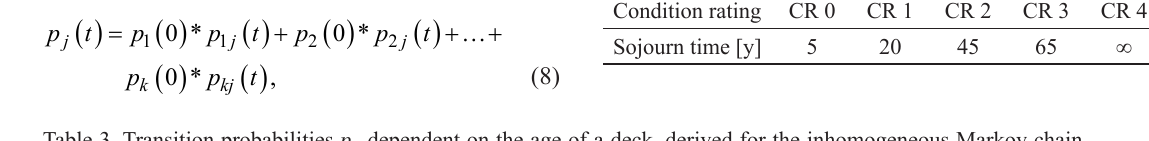
Table 3. Transition probabilities p ij dependent on the age of a deck, derived for the inhomogeneous Markov